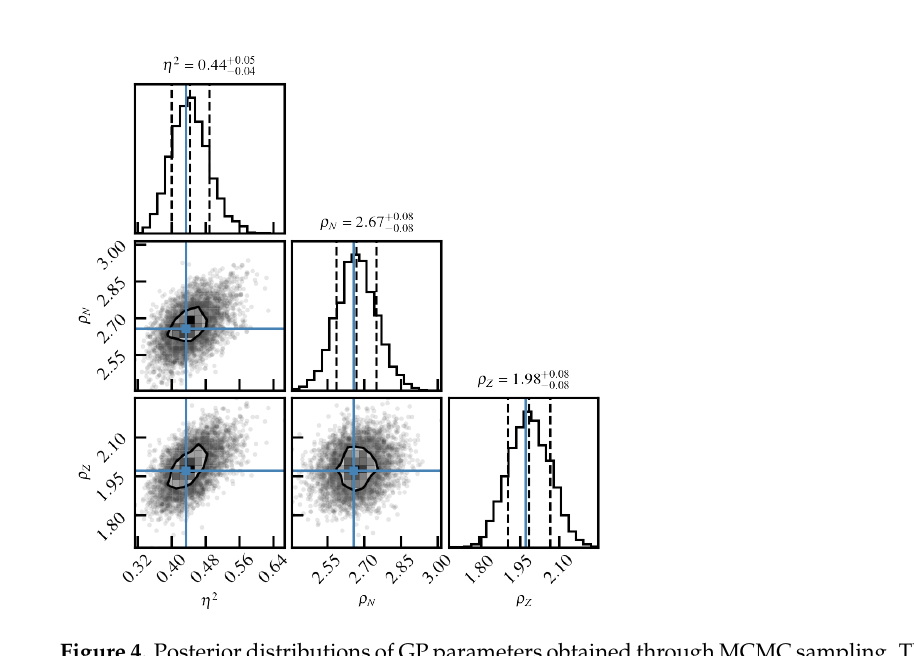
Figure 4. Posterior distributions of GP parameters obtained through MCMC sampling. The horizontal and vertical solid lines indicate the optimal parameter values obtained by maximising the likelihood. The vertical dotted lines on each 1D histogram indicate the mean and 1 σ confidence intervals obtained through MCMC sampling. See text for details.